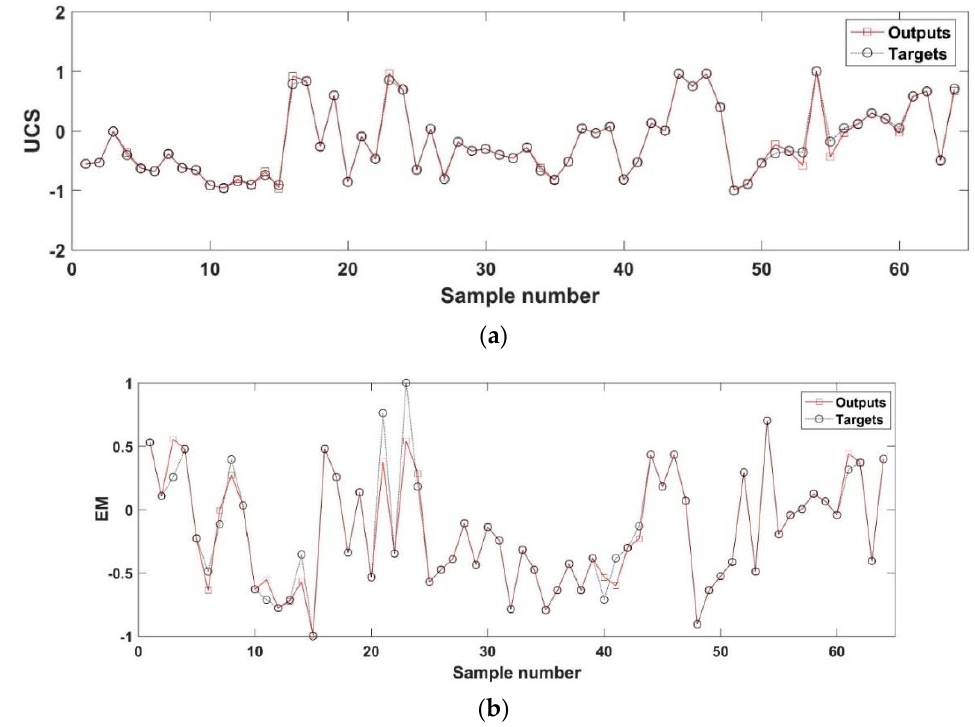
Figure 10. The error value using the ANFIS approach ( a ) for EM prediction and ( b ) for UCS prediction.